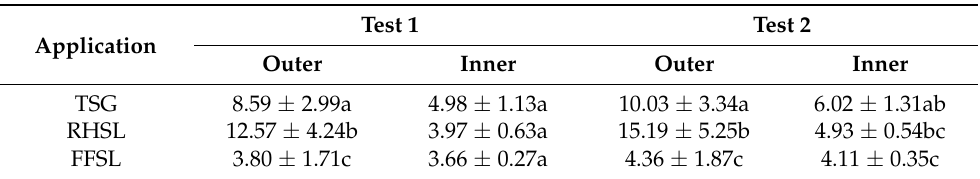
Table 4. Normalised deposition (in µ L cm − 2 ) in the outer and inner zones of the ground (mean ±